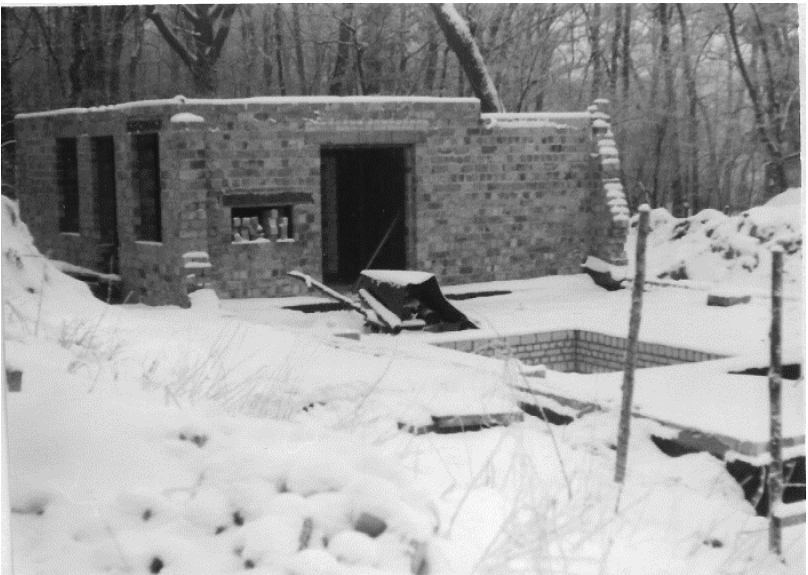
Figure 2. Construction site of the first high pressure hall with a pit for the triaxial press (6 January 1971).